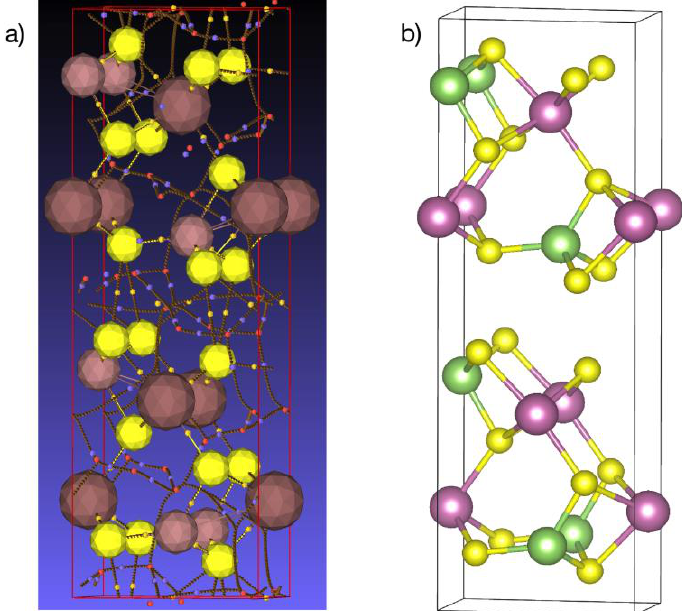
Figure 13. ( a ) Network of bond critical points (small yellow spheres), ring critical points (small red spheres), and cage critical points (small blue spheres). Sulfur atoms: large yellow spheres; gallium atoms: small brown spheres; and indium atoms: large brown spheres. ( b ) Corresponding atomic positions in the crystal structure. Sulfur in yellow, gallium in green, and indium in pink. View along the {001} direction; the gap between the layers is along the {100} direction.